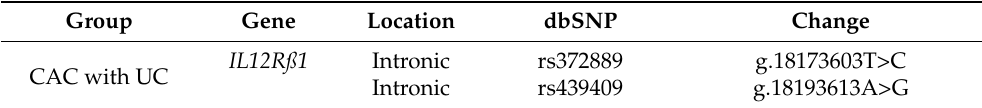
Table 3. List of somatic variants from UC and CRC that co-exist with CAC group. UC, ulcerative colitis; CRC, colorectal cancer; CAC, colitis-associated